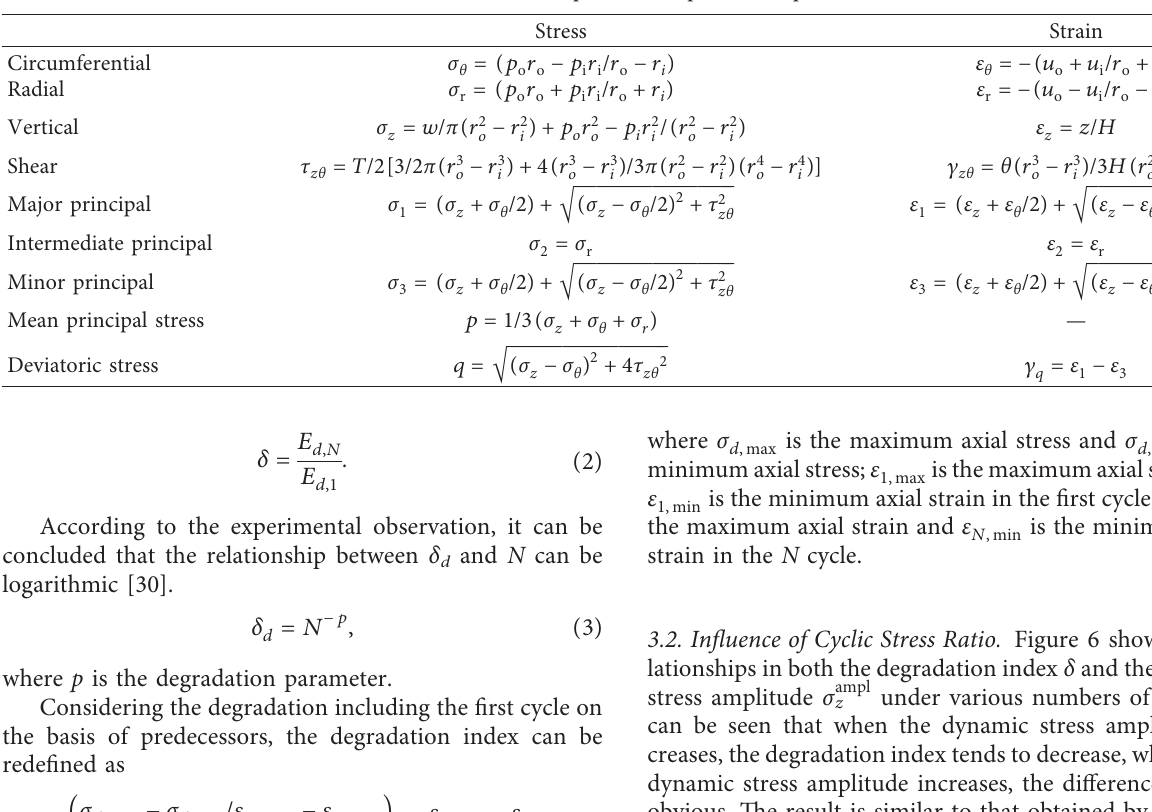
Figure 3: Thin-walled unit stress state diagram. Table 2: Stress component interpretation